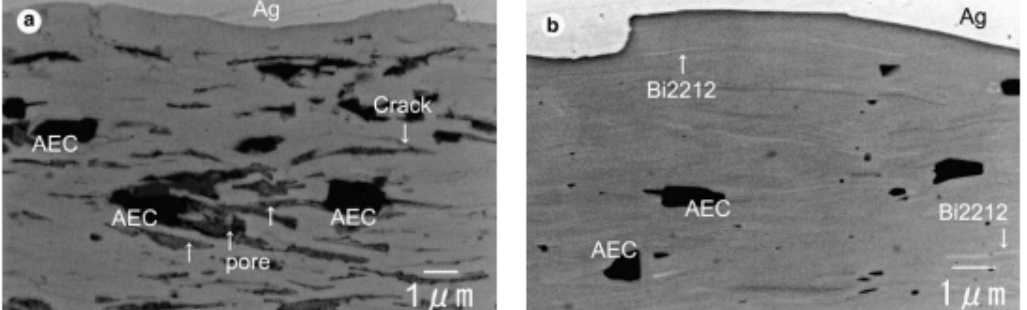
Figure 4. Comparison of SEM secondary electron micrographs of ( a ) Bi-2223 normal-pressure fila- ment and ( b ) overpressure filament. AEC is alkaline earth cuprate, such as (Ca,Sr)-Cu-O [19]. Adapted with permission from Ref. [19]. 2005, Elsevier.